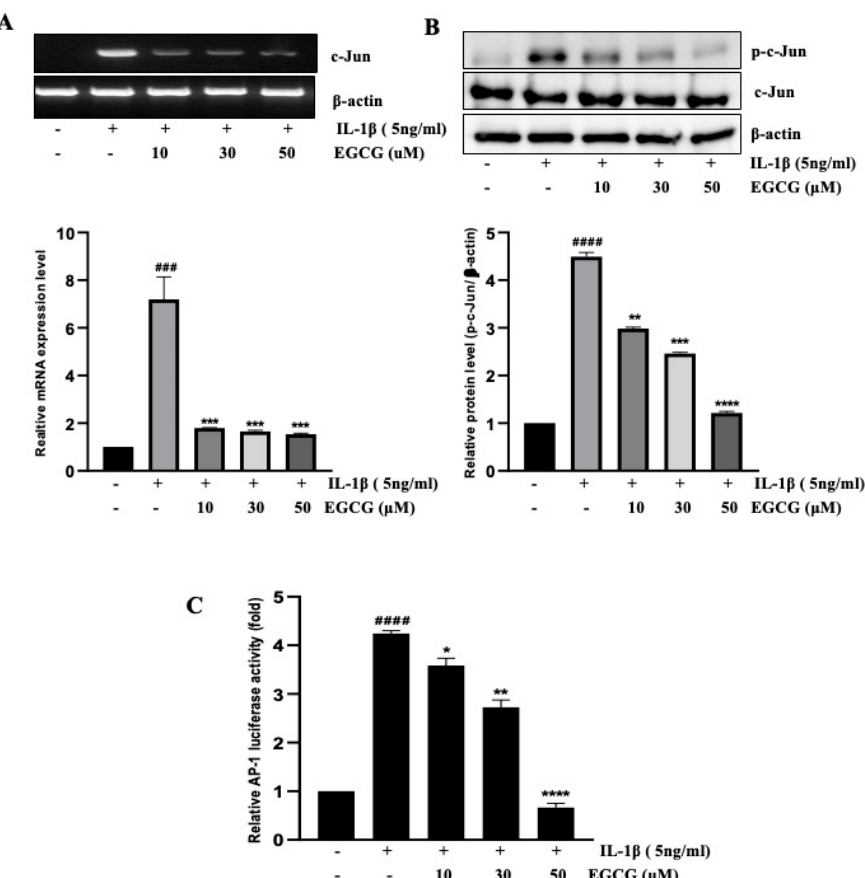
Figure 4. EGCG inhibits IL-1 β -induced uPAR expression by suppressing the transcriptional activity of AP-1 in T24 cells. ( A ) T24 cells were pretreated with EGCG (10, 30, and 50 µ M) for 1 h and then 5 ng/mL IL-1 β for 4 h, and the cells were then extracted for mRNA to check uPAR expression by RT-PCR for the c-Jun expression. T24 cells were pretreated again with different concentrations of EGCG followed by 5 ng/mL IL-1 β for 30 min of treatment and the phosphorylation of c-Jun expression by performing Western blotting ( B ). ( C ) Cells were pretreated with EGCG (10, 30, and 50 µ M), were transiently transfected with the AP-1 luciferase reporter plasmid and were incubated with 5 ng/mL IL-1 β ; the cells were lysed, and luciferase activity was determined. The above data represent the mean ± SD from triplicate measurements ( ### p < 0.001, #### p < 0.0001 versus control; * p < 0.05, ** p < 0.01, *** p < 0.001, **** p < 0.0001 versus IL-1 β